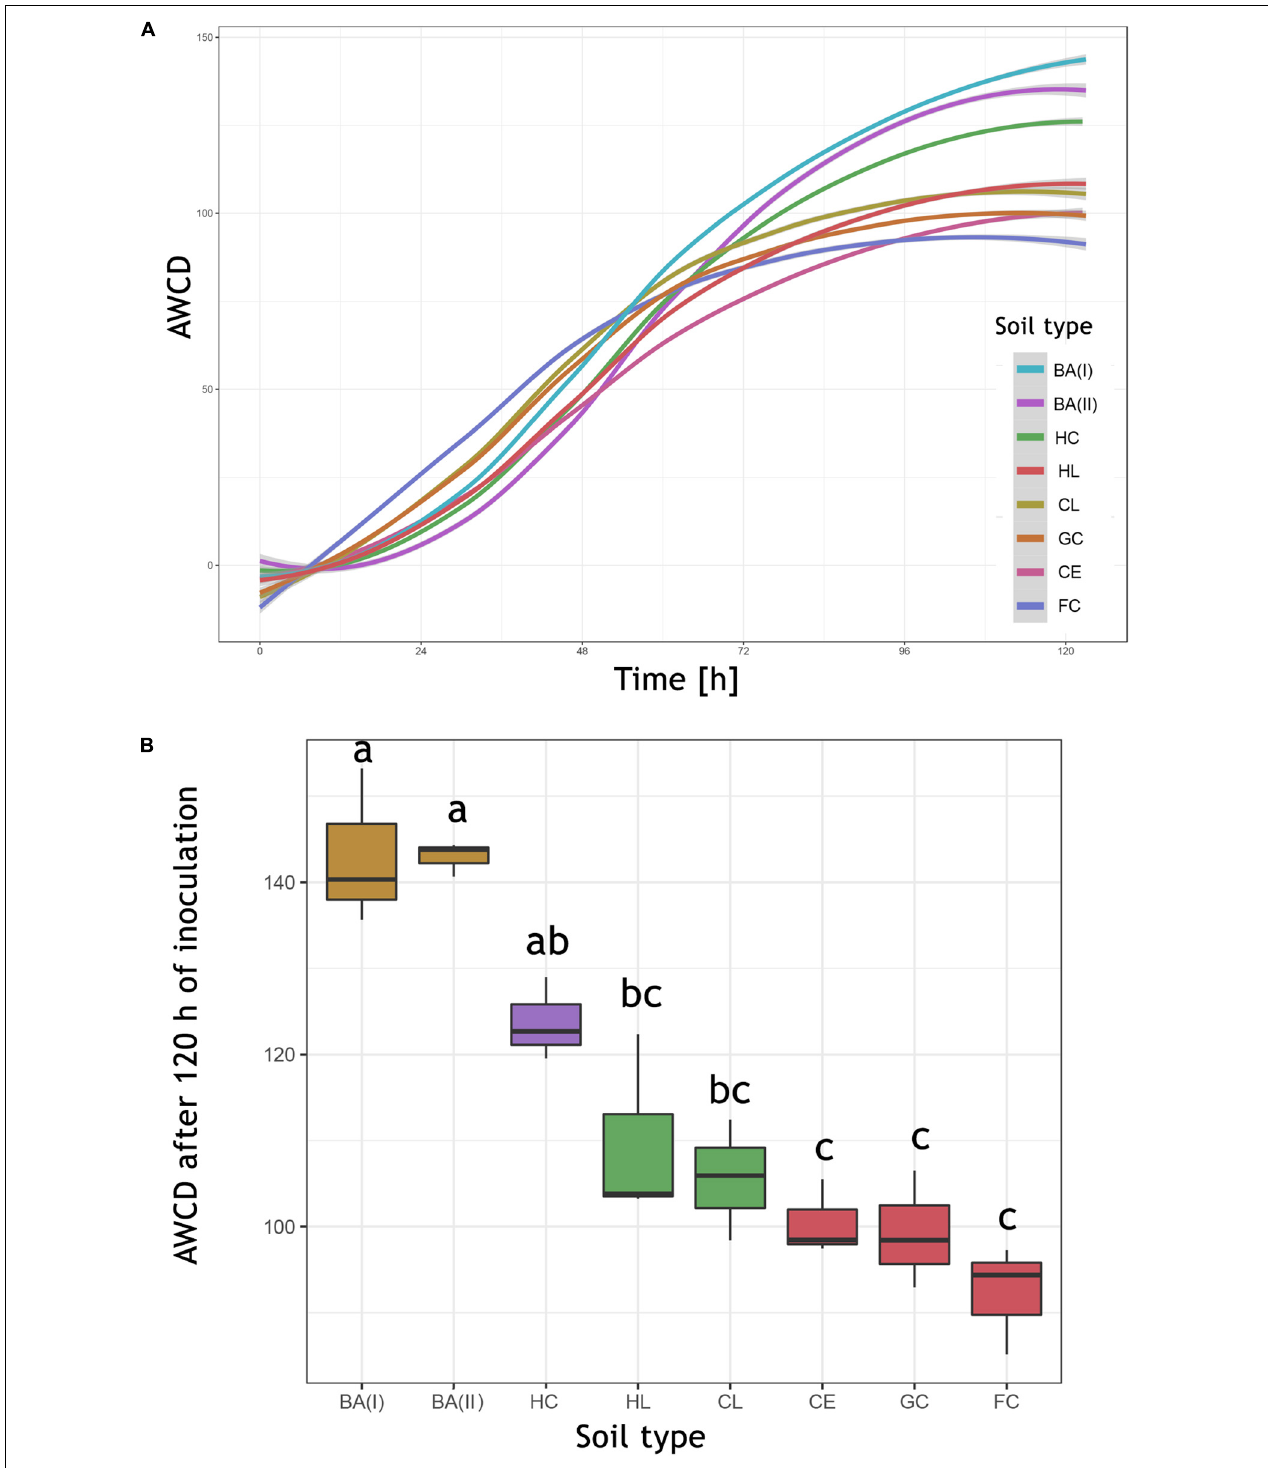
FIGURE 6 | The AWCD (average well color development) expressed in Biolog R (cid:13) OmniLog Units. (A) Kinetics of the mean AWCD from replicates ( n = 3). (B) AWCD at 120 h, boxplot illustrating the median of AWCD (horizontal line), upper and lower quartile (corresponding borders of the boxplot), significant differences calculated by Tukey HSD test are indicated by letters. HC, Haplic Cambisol; BA (I, II), Brunic Arenosols I and II; HL, Haplic Luvisol; CL, Cambic Leptosol; GC, Gleyic Chernozem; CE, Cambisol (Eutric); FC, Fluvic Cambisol.